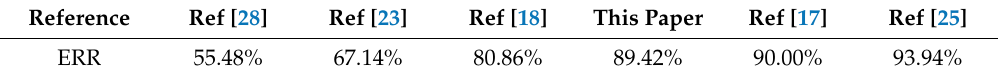
Table 3. The position compensation effects of different schemes.